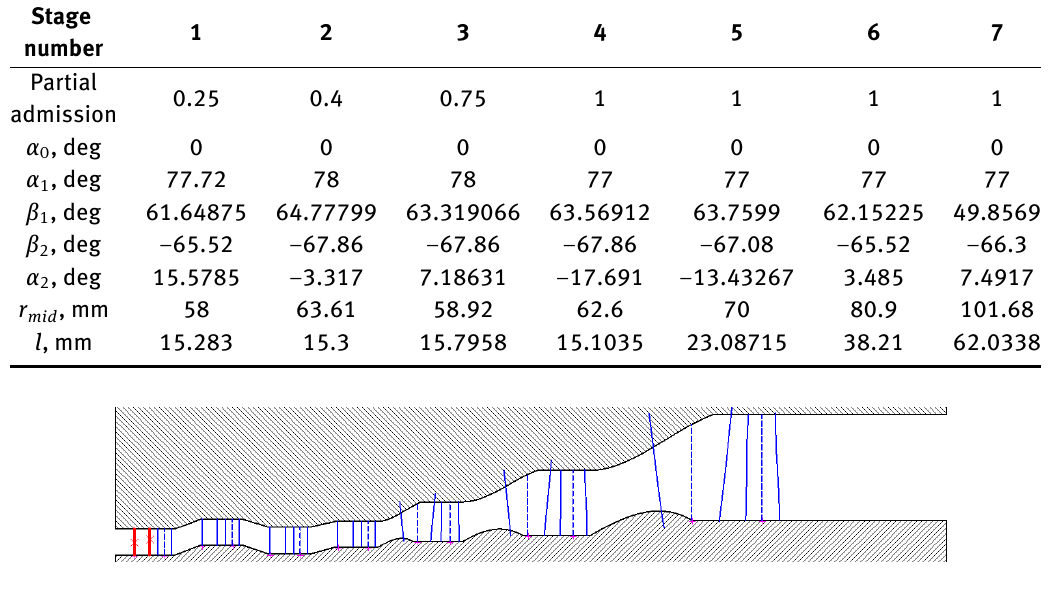
Figure 10. Expansion turbine MTDA-3,0-10,4-MP-U2